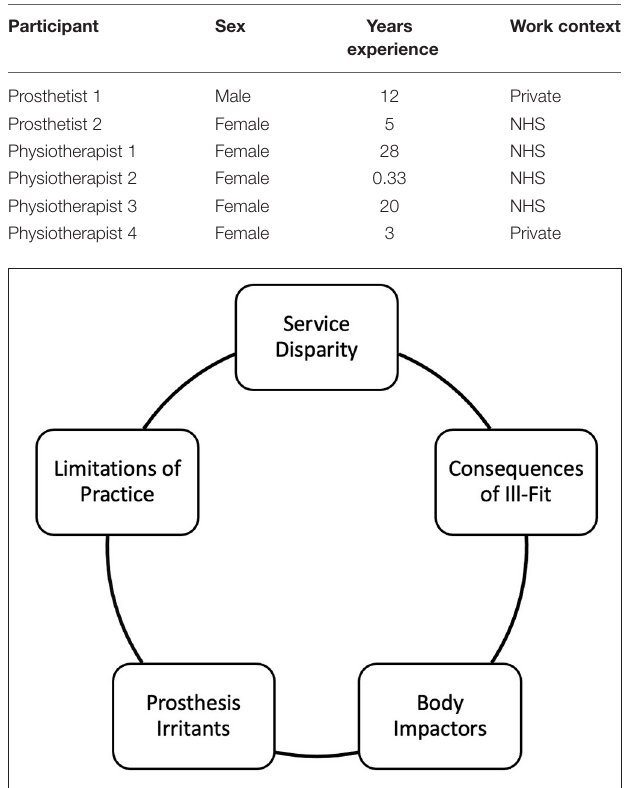
TABLE 1 | Participant demographics, n = 6.